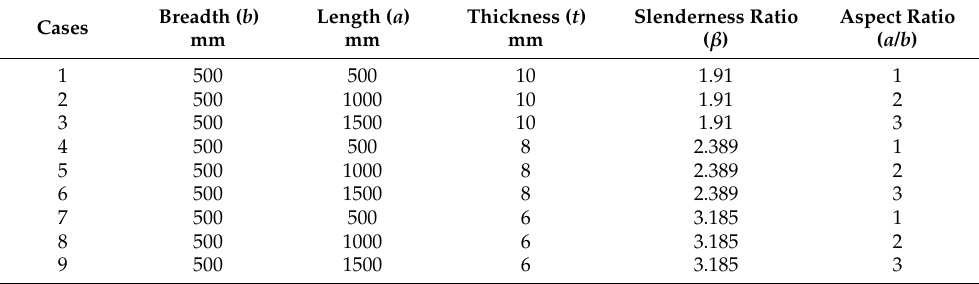
Table 4. Different geometrical cases analyzed, showing the slenderness ratio β and aspect ratio a / b .